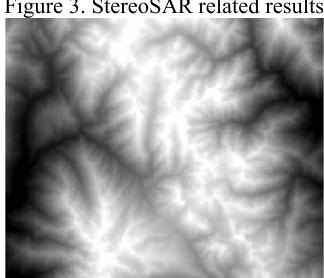
Figure 4. Combined adjustment results